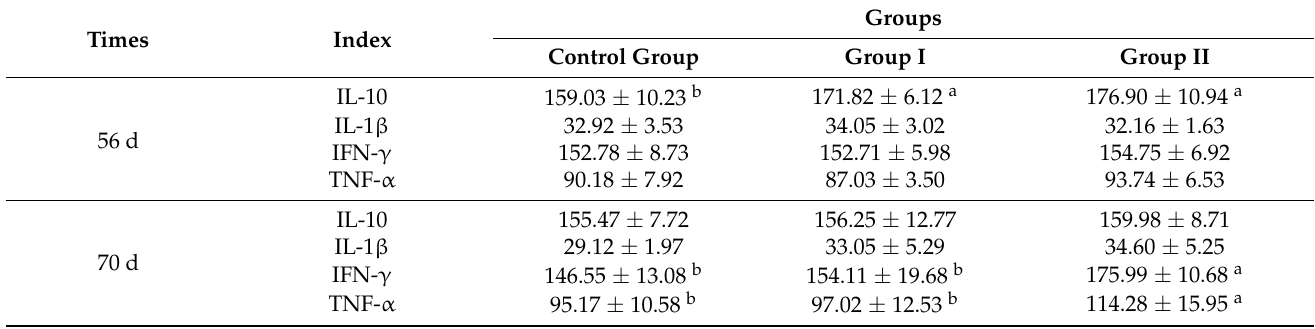
Table 9. Effects of feed restriction and compensation on inflammatory factors in rabbits (ng/gprot).